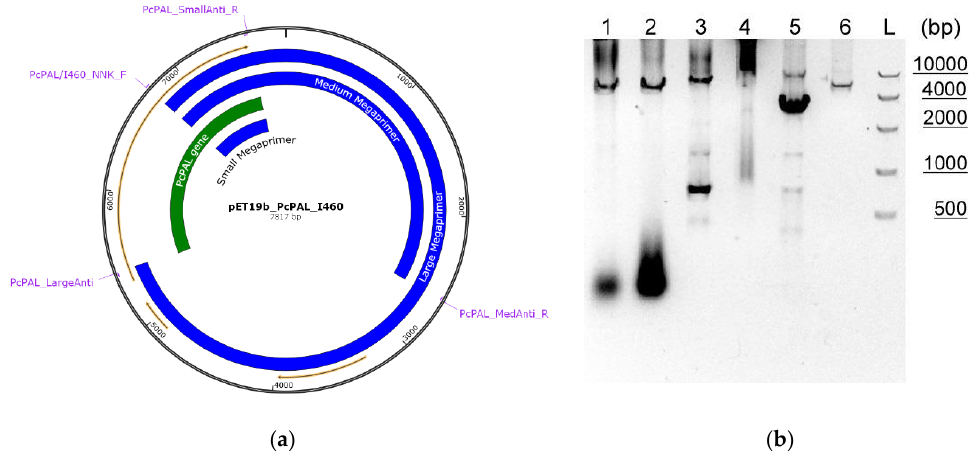
Figure 1. ( a ) Saturation mutagenesis using the Megaprimers procedure, representing the gene encoding Pc PAL ( green ), the pET19b-vector backbone ( black ), and the megaprimers of the different, small, medium, large lengths ( blue ). In the first PCR stage, the forward mutagenic primer and the reverse, antiprimer anneal to the template resulting the amplified sequences of the corresponding, large, medium, and small-sized megaprimers. In the second PCR stage through annealing of the forward primer and the obtained megaprimers, the mutated plasmid products are obtained. ( b ) Agarose gel analysis of the PCR products obtained through the different mutagenesis procedures: lanes 1, 2 using the two sets of partially overlapping primers, lane 3 small-megaprimer protocol, lane 4 large-megaprimer protocol, lane 5 medium-megaprimer protocol, lane 6 optimized small-megaprimer protocol, L 10 kb DNA